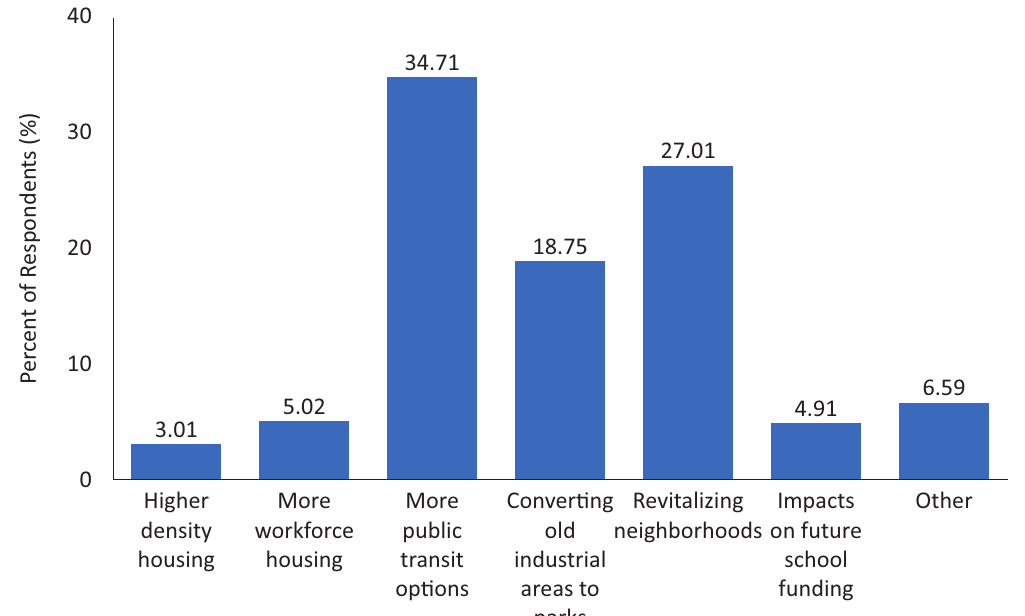
Figure 2. Best part of the BeltLine identified by respondents.